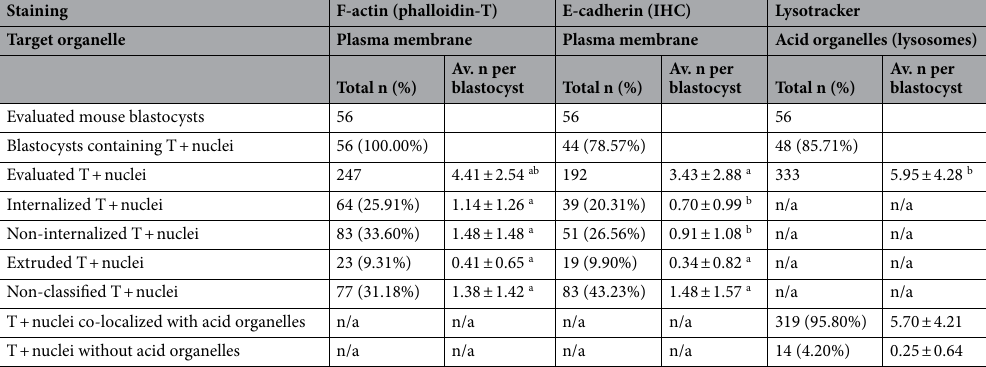
Table 3. Analysis of efferocytosis in mouse blastocysts using different types of fluorescence staining. Results are expressed as arithmetical means ± standard deviation or percentages; T + , TUNEL positive labelling. Different superscript letters indicate significant differences. Statistical analysis: mean number of evaluated TUNEL + nuclei: Kruskal–Wallis test ( P = 0.003), followed by Dunn’s test; mean number of internalized TUNEL + nuclei: Mann–Whitney U test ( P = 0.048); mean number of non-internalized TUNEL + nuclei: Mann–Whitney U test ( P = 0.039); mean number of extruded TUNEL + nuclei: Mann–Whitney U test ( P = 0.312); mean number of non-classified TUNEL + nuclei: Mann–Whitney U test ( P = 0.874); Proportion of internalized, non-internalized, extruded and non-classified TUNEL + nuclei: Chi-squared test with three degrees of freedom ( P =